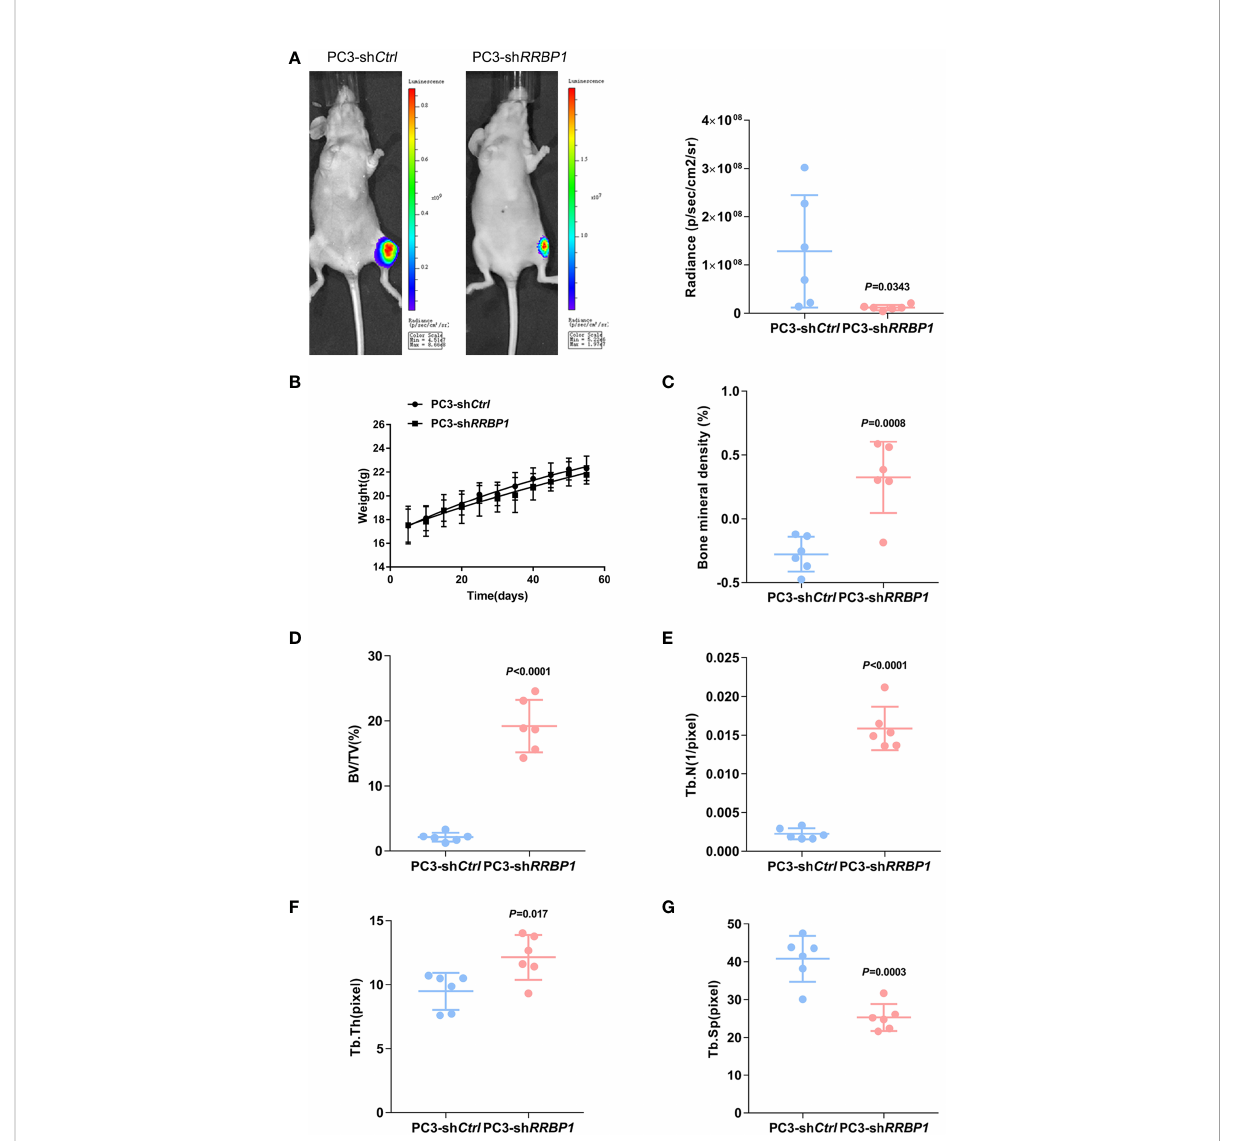
FIGURE 3 The effect of injection with PC3 transduced with shRRBP1 into the proximal metaphysic of the tibia on bone mass in a nude mouse model. PC3 cells transduced with sh RRBP1 were injected into the proximal metaphysic of the tibia in nude mice for 8 w. (A) The radiance (p/sec/cm2/sr) of tumor mass was measured using the IVIS Lumin II in vivo imagining. (B) Mouse body weight was measured and analyzed using GraphPad Prism 6 software. (C – G) Quantitative analysis of structural parameters of the tibia by high-resolution micro-CT scanning: bone mineral density (C) , bone volume/total tissue volume (BV/TV) (D) , trabecular number (Tb. N) (E) , trabecular thickness (Tb. Th) (H) , and Trabecular Space (Tb. Sp) (G)